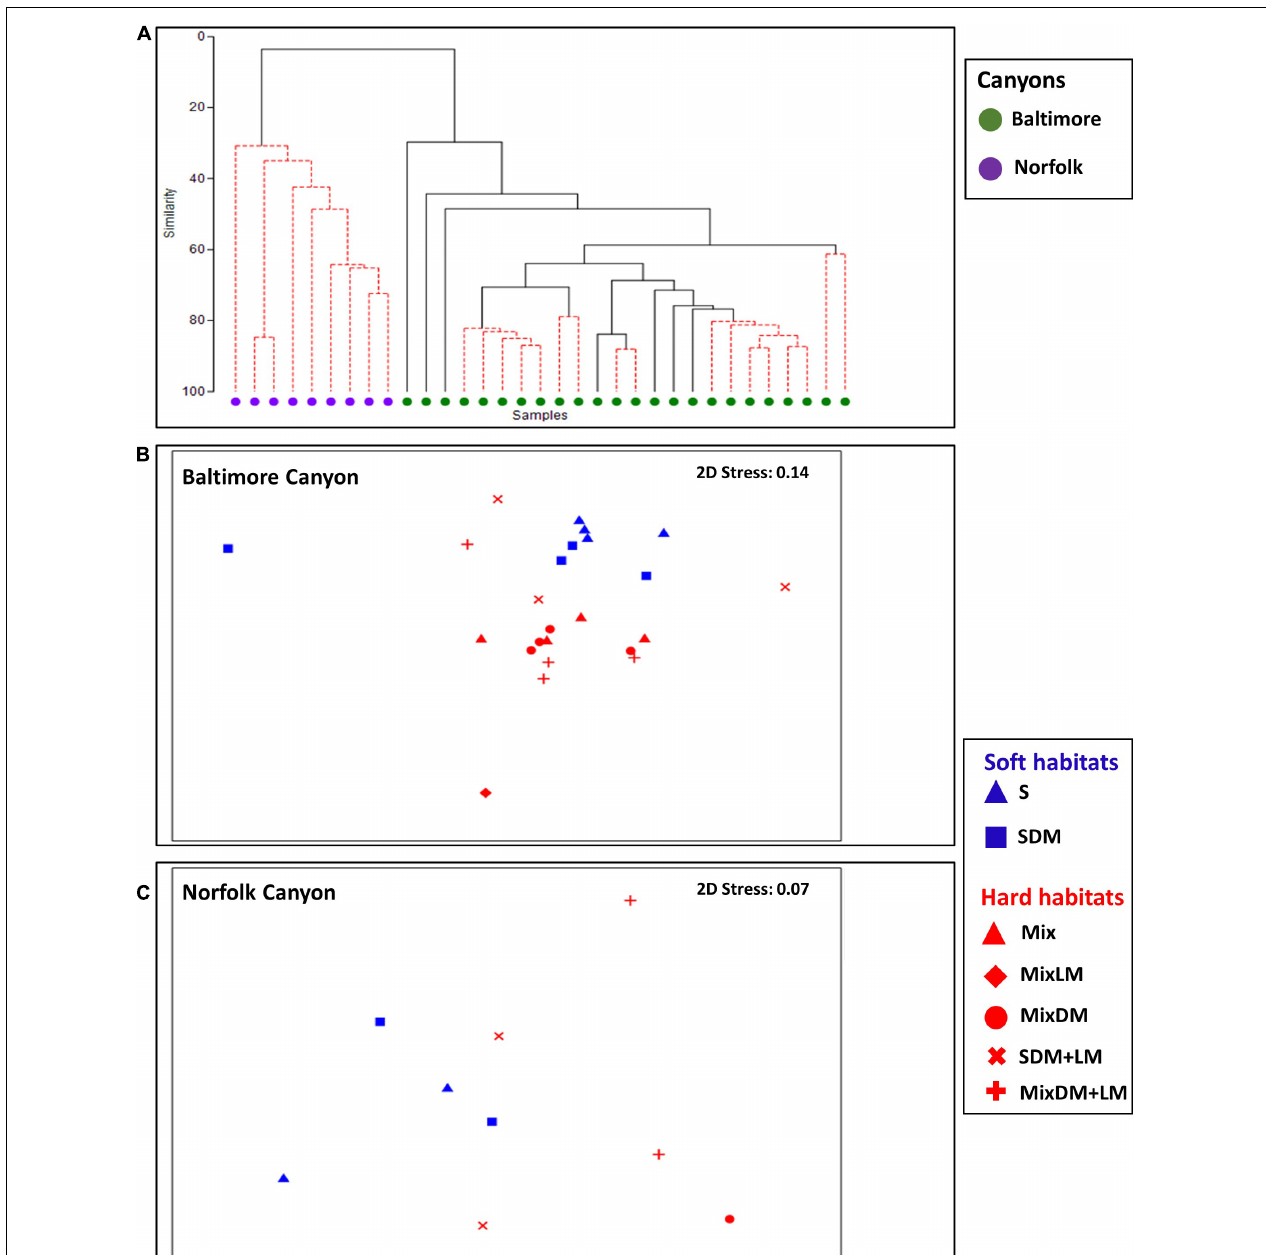
FIGURE 5 | Non-metric multidimensional scaling showing the grouping of samples (A) at Baltimore Canyon (BC) and Norfolk Canyon (NC), (B) across habitats at BC, and (C) across habitats at NC.